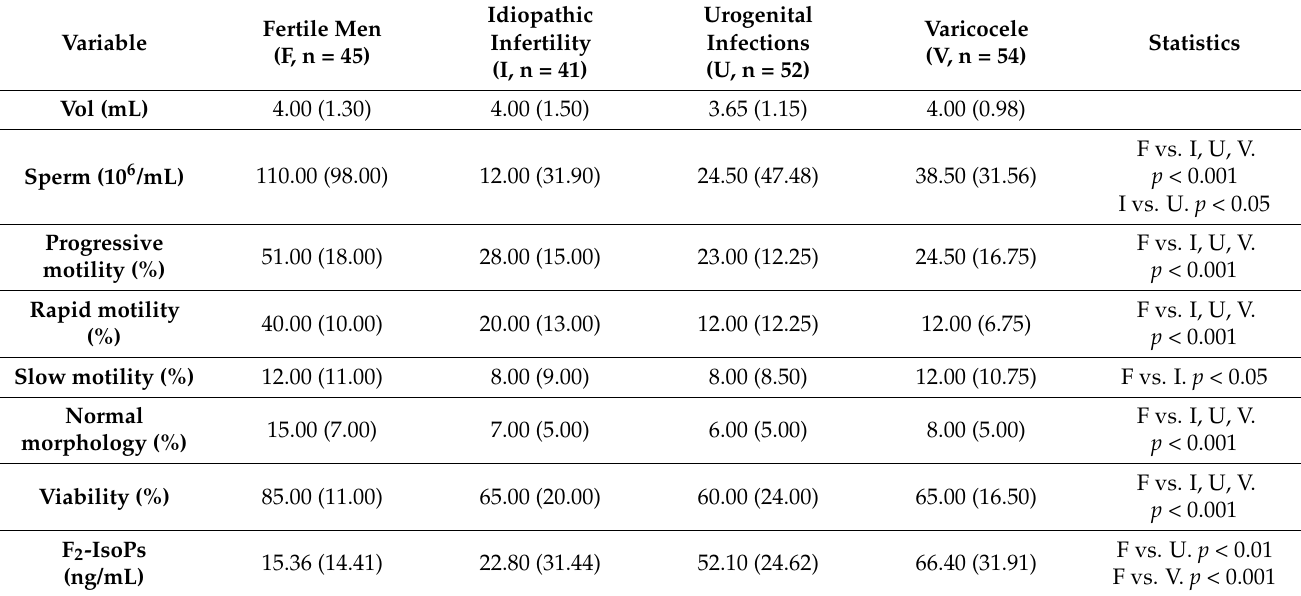
Table 2. Median (IQR) of semen variables in each categorized group (fertile, idiopathic infertility, urogenital infection and